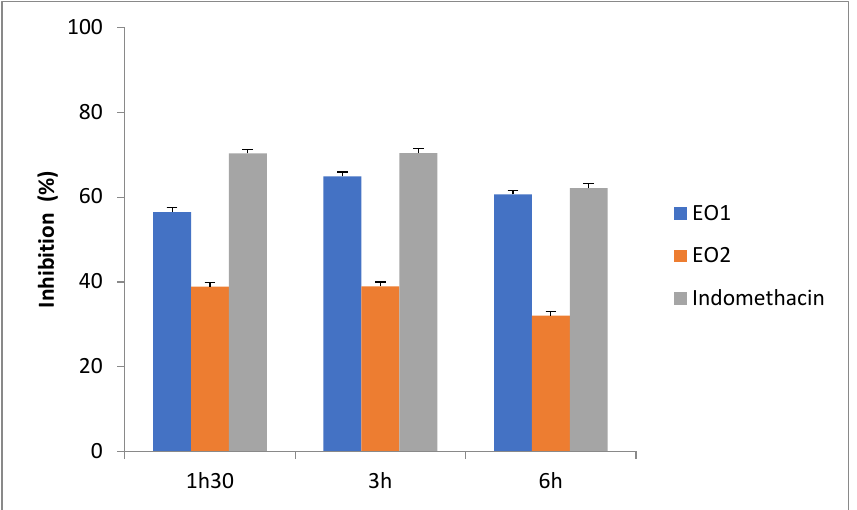
Figure 1. Effects of indomethacin, O. compactum essential oils on carrageenan induced rat paw edema.